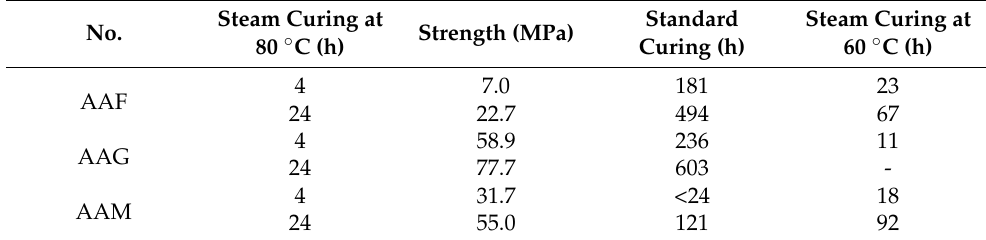
Table 2. Relationship between the strength and curing time of alkali-activated mortar. Steam Curing No.